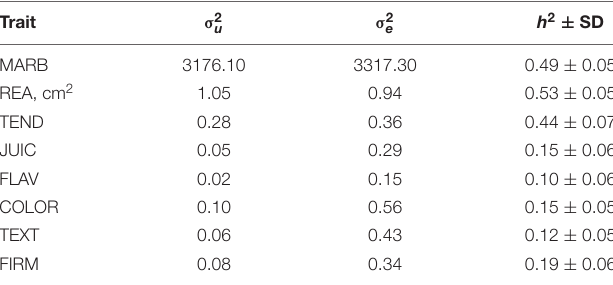
TABLE 2 | Single-trait AIREML estimates of genetic variances ( σ 2 u ), and residual variances ( σ 2 e ), and heritabilities ( h 2 ) with standard deviation (SD) for marbling, rib eye area, juiciness, flavor, tenderness, color, texture, and firmness in a multibreed Angus–Brahman population.